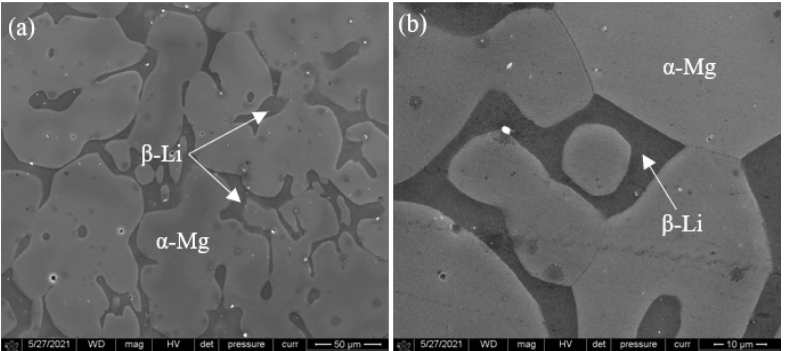
Figure 2. Different magnification microstructure of Mg-6Li alloy after homogenization treatment. ( a ) 1000×, ( b ) 4000×.